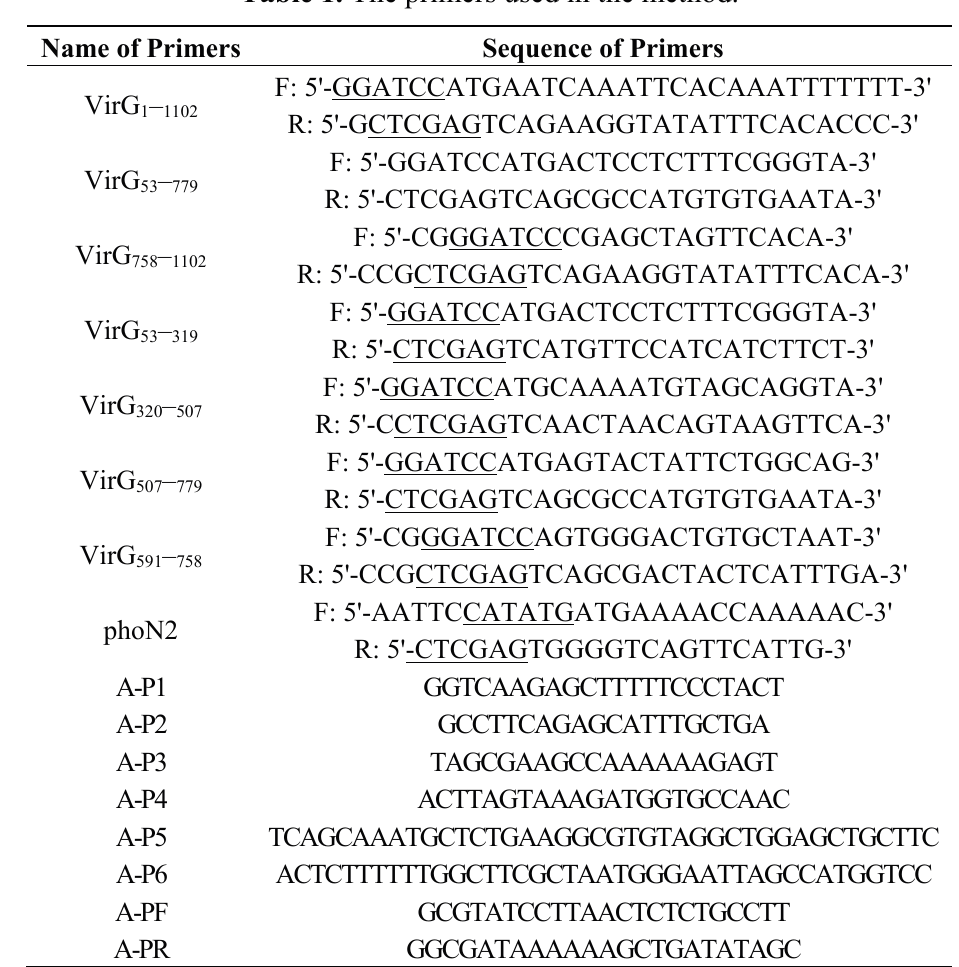
Table 1. The primers used in the